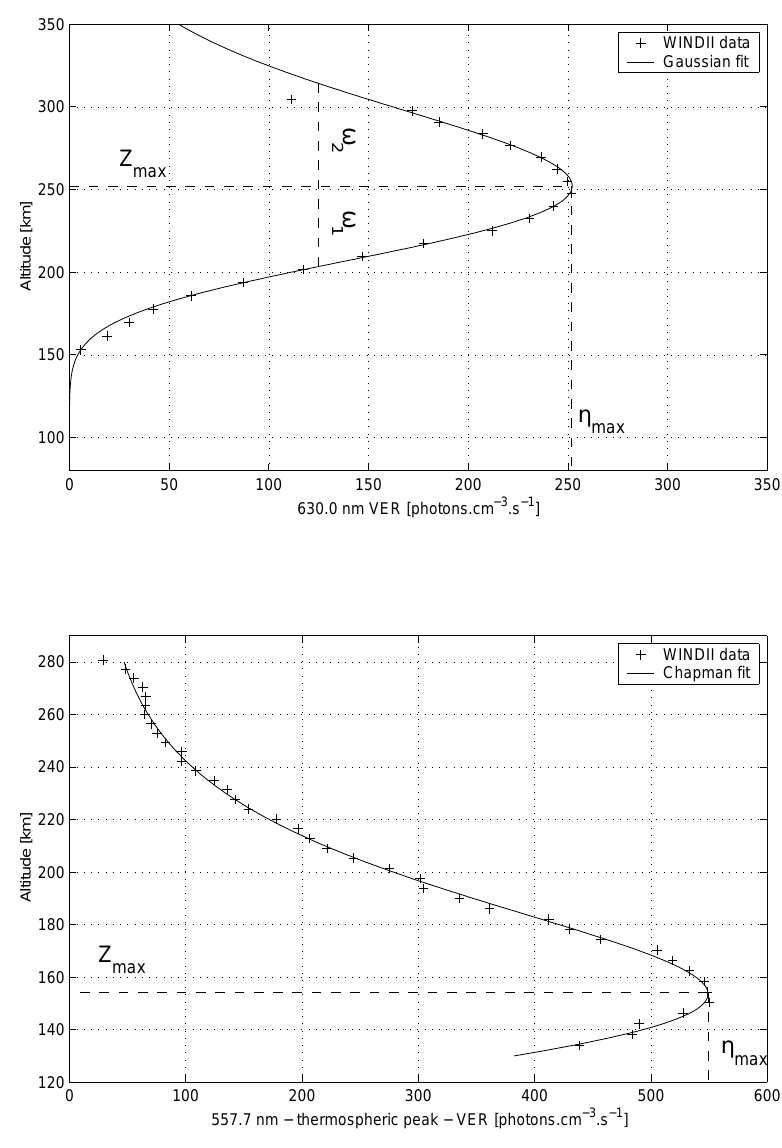
Fig. 5. The (top) 630.0nm Volume Emission Rate fitted by a Gaussian function and (bottom) 557.7nm thermospheric peak fitted by a chapman